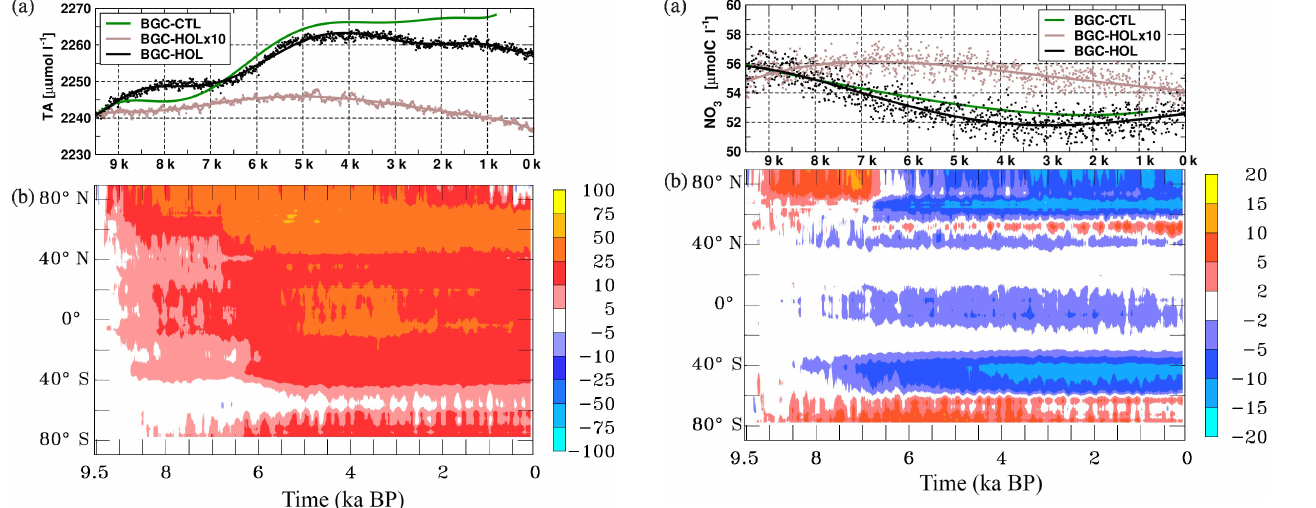
Figure 7. As Fig. 2, but for (a) time series of global mean total al- kalinity (TA) at the surface in µmolL − 1 as eighth-order polynomial fit, and (b) Hovmöller diagram of the changes in zonal and annual mean surface TA in µmolL − 1 .